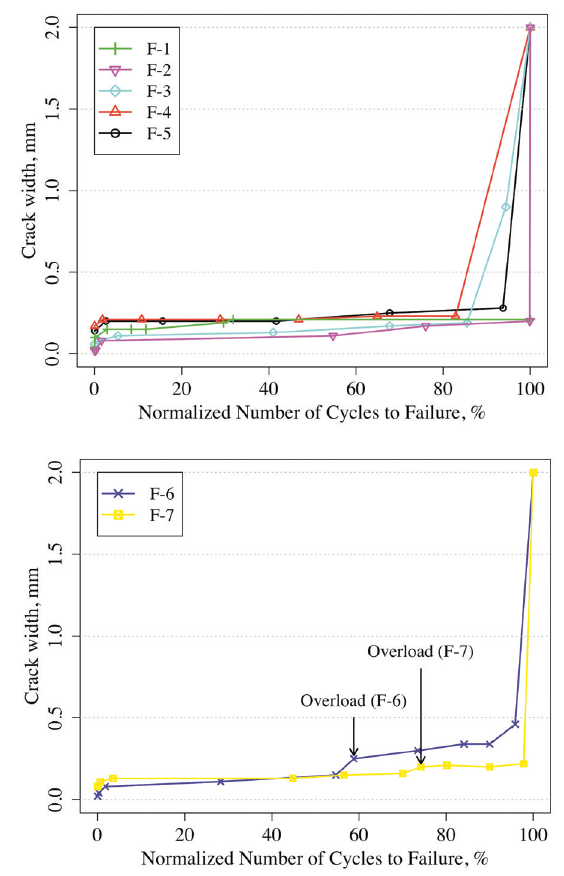
Figure 5. Crack widths versus normalized number of cycles to failure for beams a) F-1 to F-5 and b) F-6 &